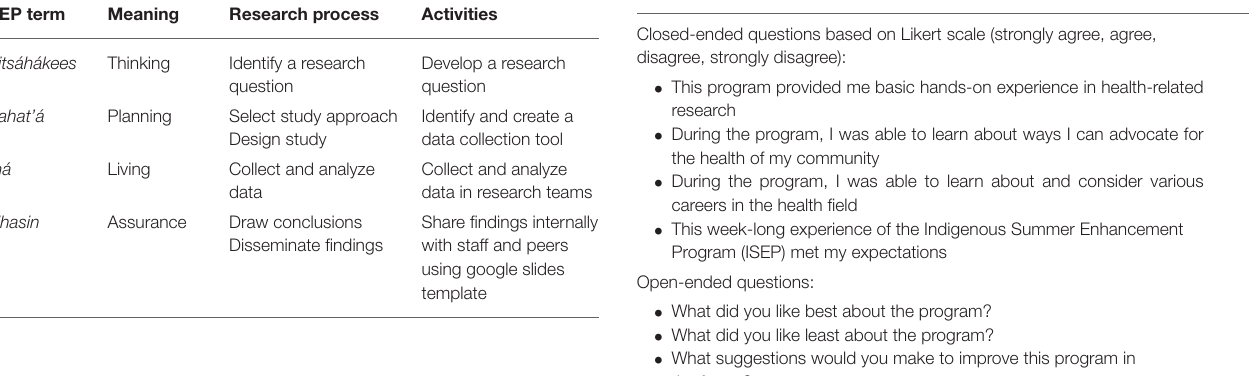
TABLE 1 | DEP research process and mini DEP experiential research activities. TABLE 2 | Program evaluation questions from post-survey with high school